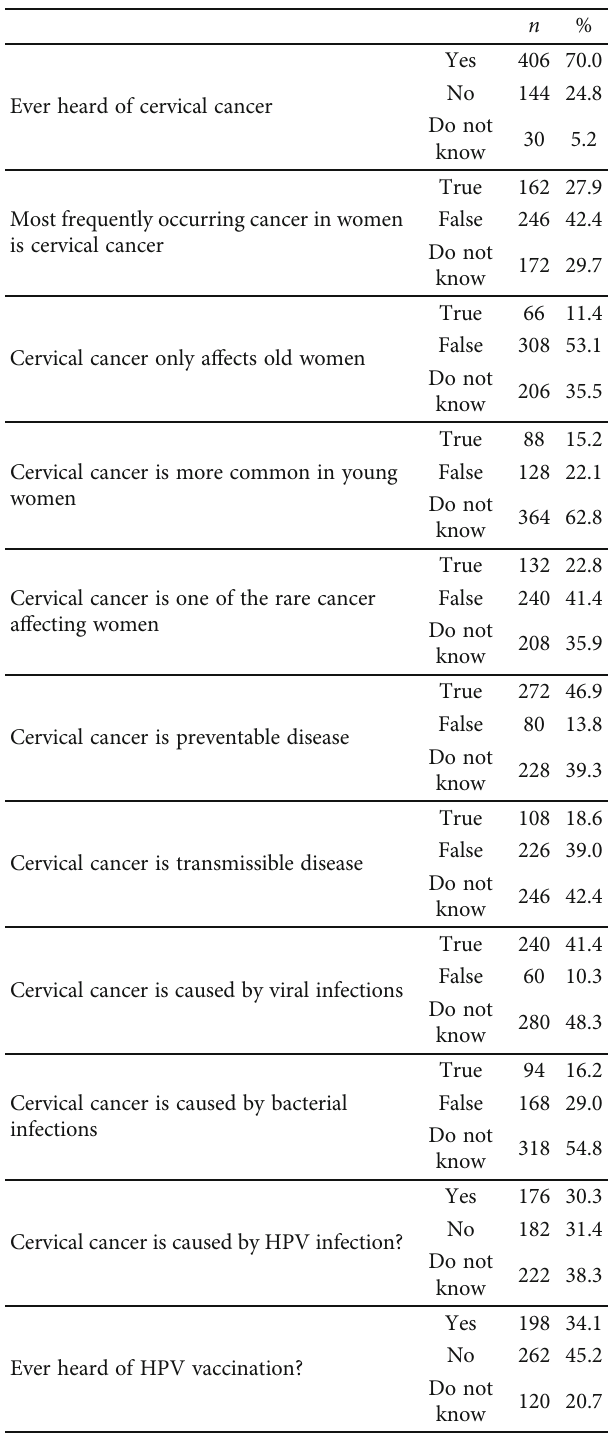
Table 2: Responses of the participants regarding the knowledge and awareness of the etiology of cervical cancer ( n = 580 ).